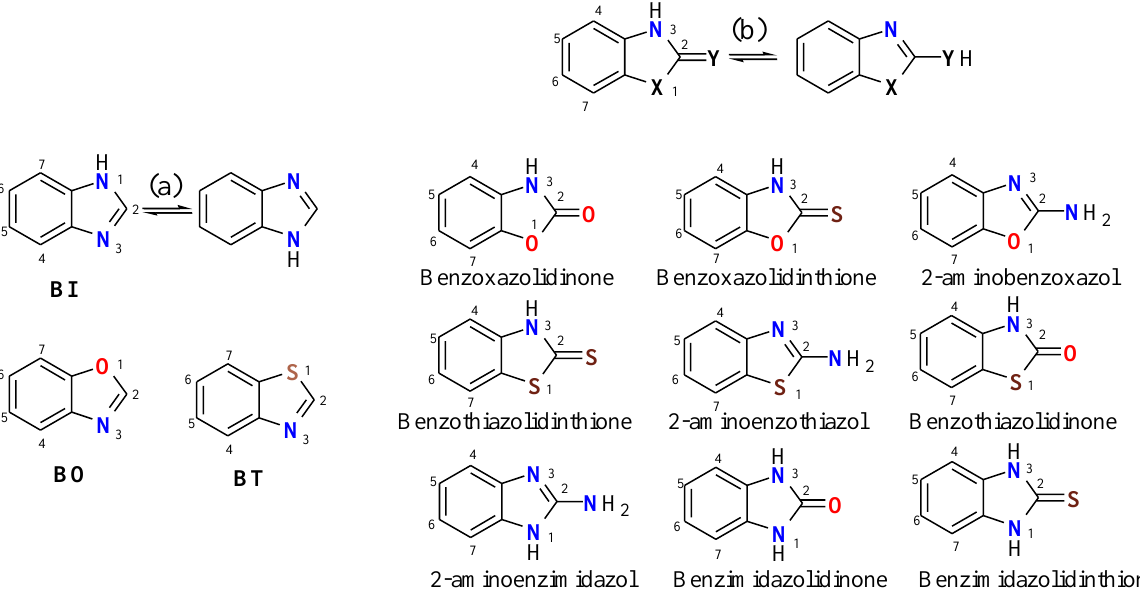
Figure 1. (a) Intracyclic and (b) exocyclic tautomerism in benzazoles (BZs). Figure 1. ( a ) Intracyclic and ( b ) exocyclic tautomerism in benzazoles (BZs). In commercial databases, the presence of tautomeric duplicates has been found, and both tautomers are offered as different products [2]. On the other hand, different names for tautomers based on the IUPAC rules have been used [3]. In general, compounds